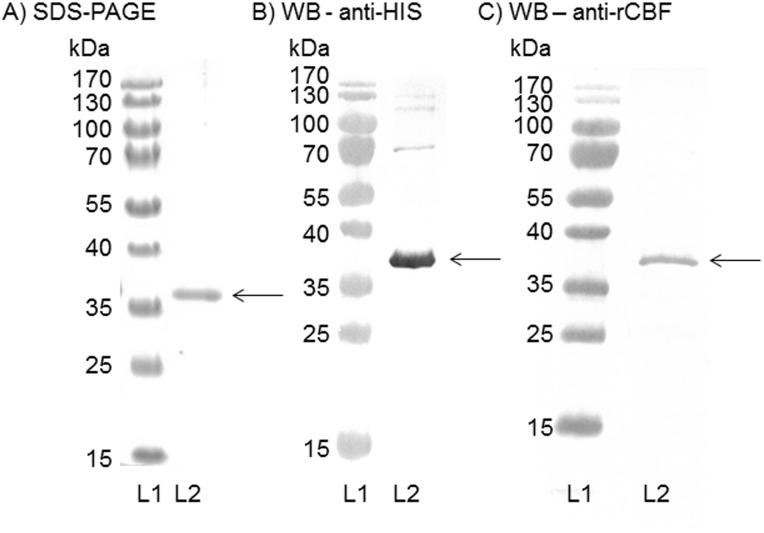
Purification of recombinant (r)CBF.The protein was purified to homogeneity using nickel-nitrilotriacetic acid metal affinity chromatography under denaturing conditions. A) SDS-PAGE analysis of purified rCBF. Lane 1, molecular mass markers; lane 2, rCBF (2 μg) showing a single band of ~36 kDa. B) Western blot analysis of purified rCBF reacted with anti-HIS tag antibody. Lane 1, molecular mass markers. Lane 2, protein reactivity with anti-HIS antibody (1/500) showing a single band of ~36 kDa. C) Western blot analysis of purified rCBF reacted with rabbit polyclonal anti-rCBF serum. Lane 1, molecular mass markers. Lane 2, protein reactivity with rabbit anti-rCBF serum (1/400) showing a single band of ~36 kDa.